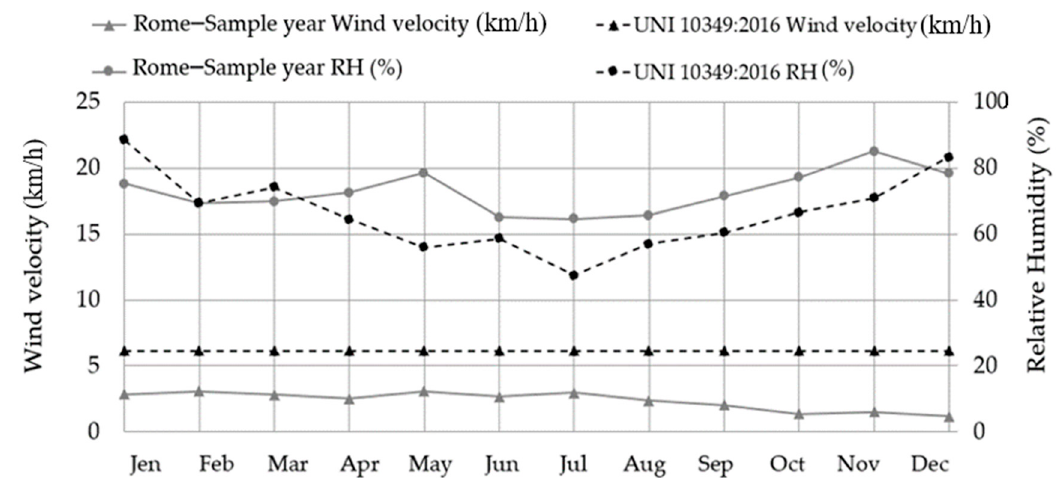
Figure 9. Sample year and UNI 10349 wind speed and relative humidity comparison.